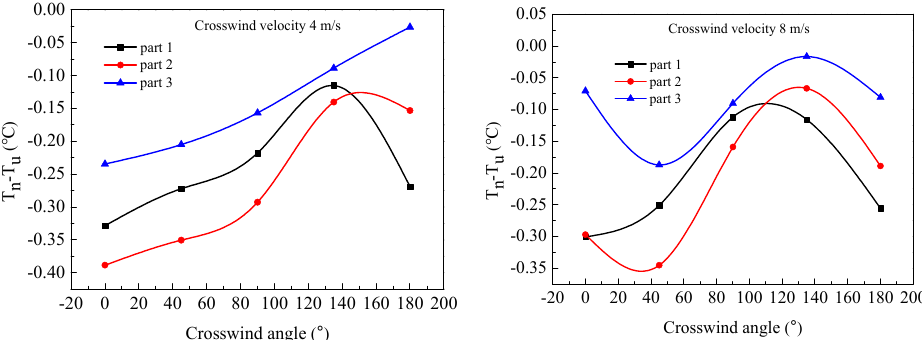
Figure 11. Water outlet temperature differences with different fill patterns.